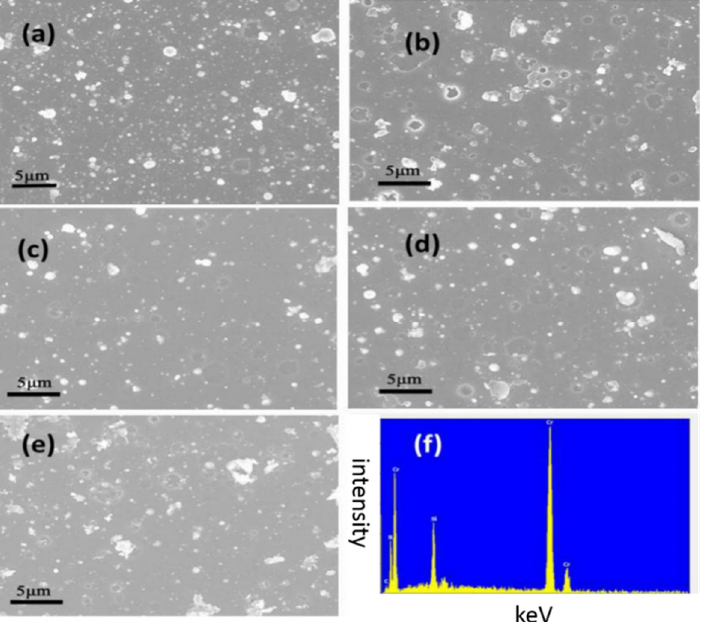
Figure 3. Surface morphology and energy spectrum of CrSiN coatings deposited under different arc currents. ( a ) 50 A, ( b ) 60 A, ( c ) 70 A, ( d ) 80 A, and ( e ) 90 A. ( f ) EDS images of coatings prepared at 70 A.